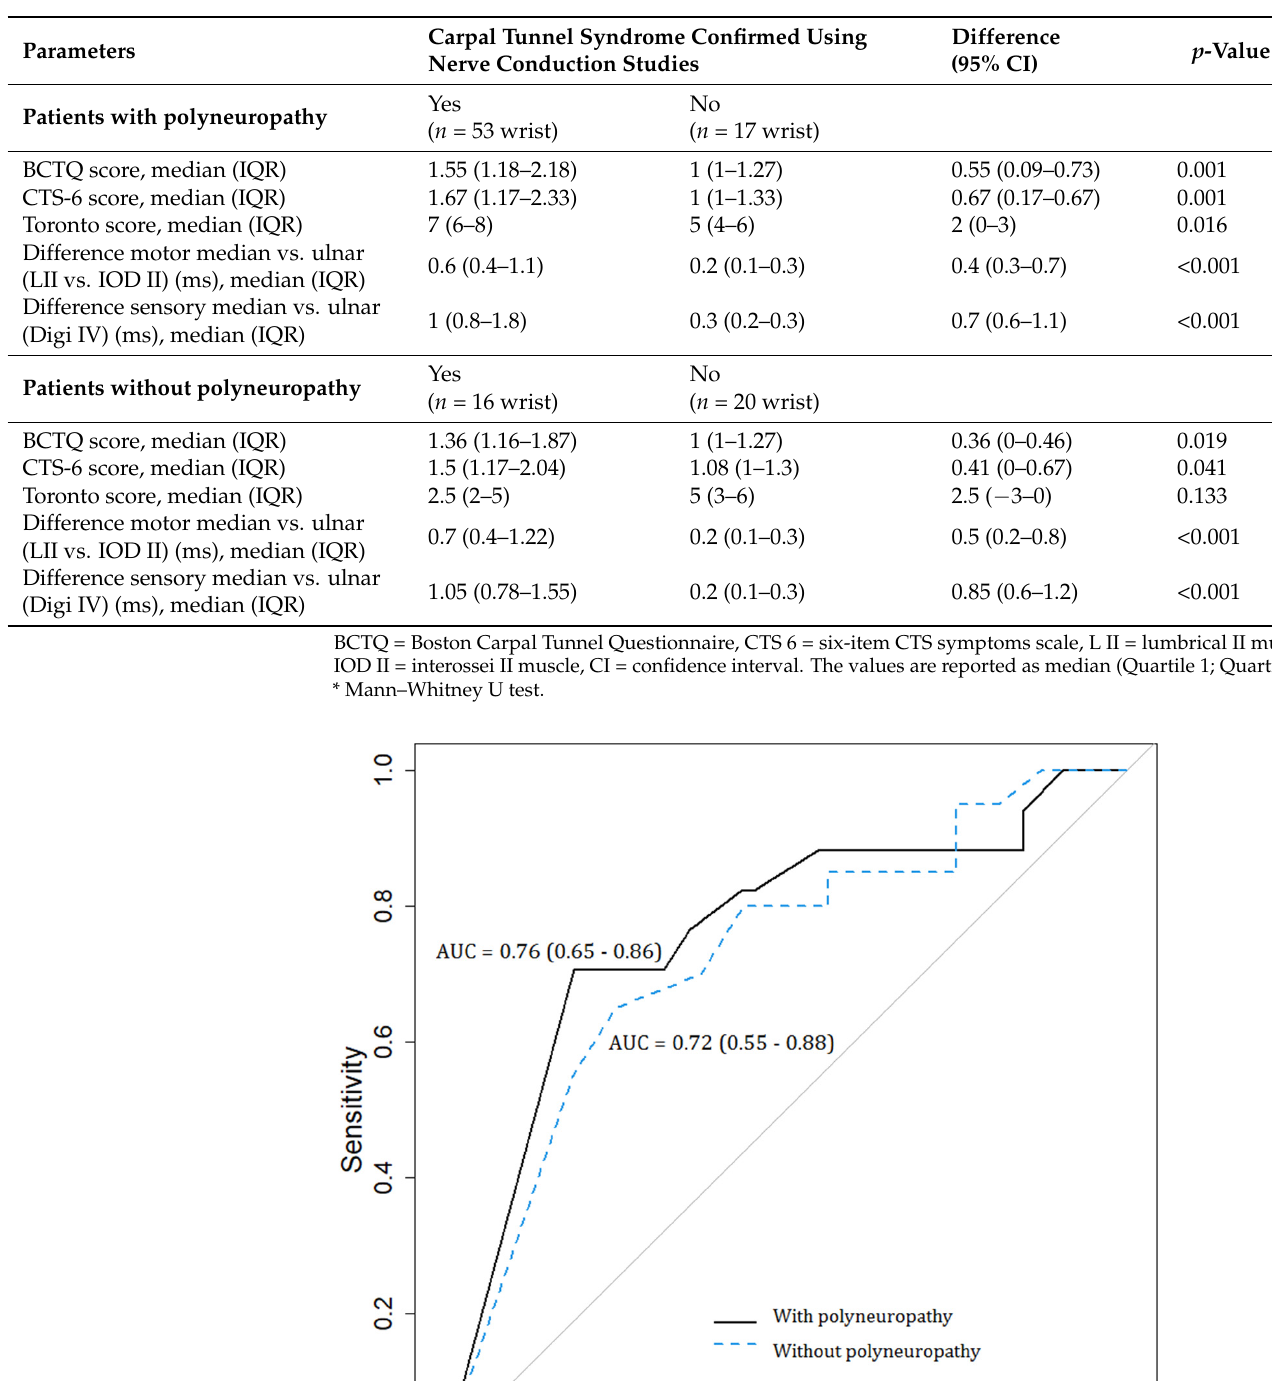
Table 2. Characteristics of patients with/without diabetic polyneuropathy and carpal tunnel syn- drome confirmed using nerve conduction studies.